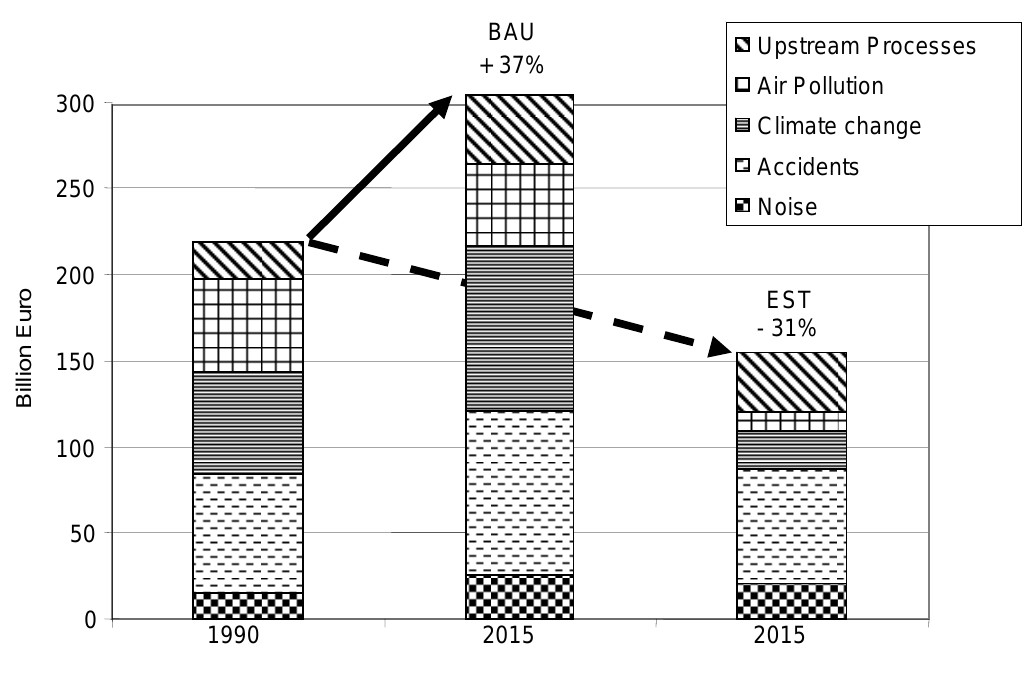
Figure 4. External costs of transport: Environmental and health costs of the BAU and EST scenarios by impact